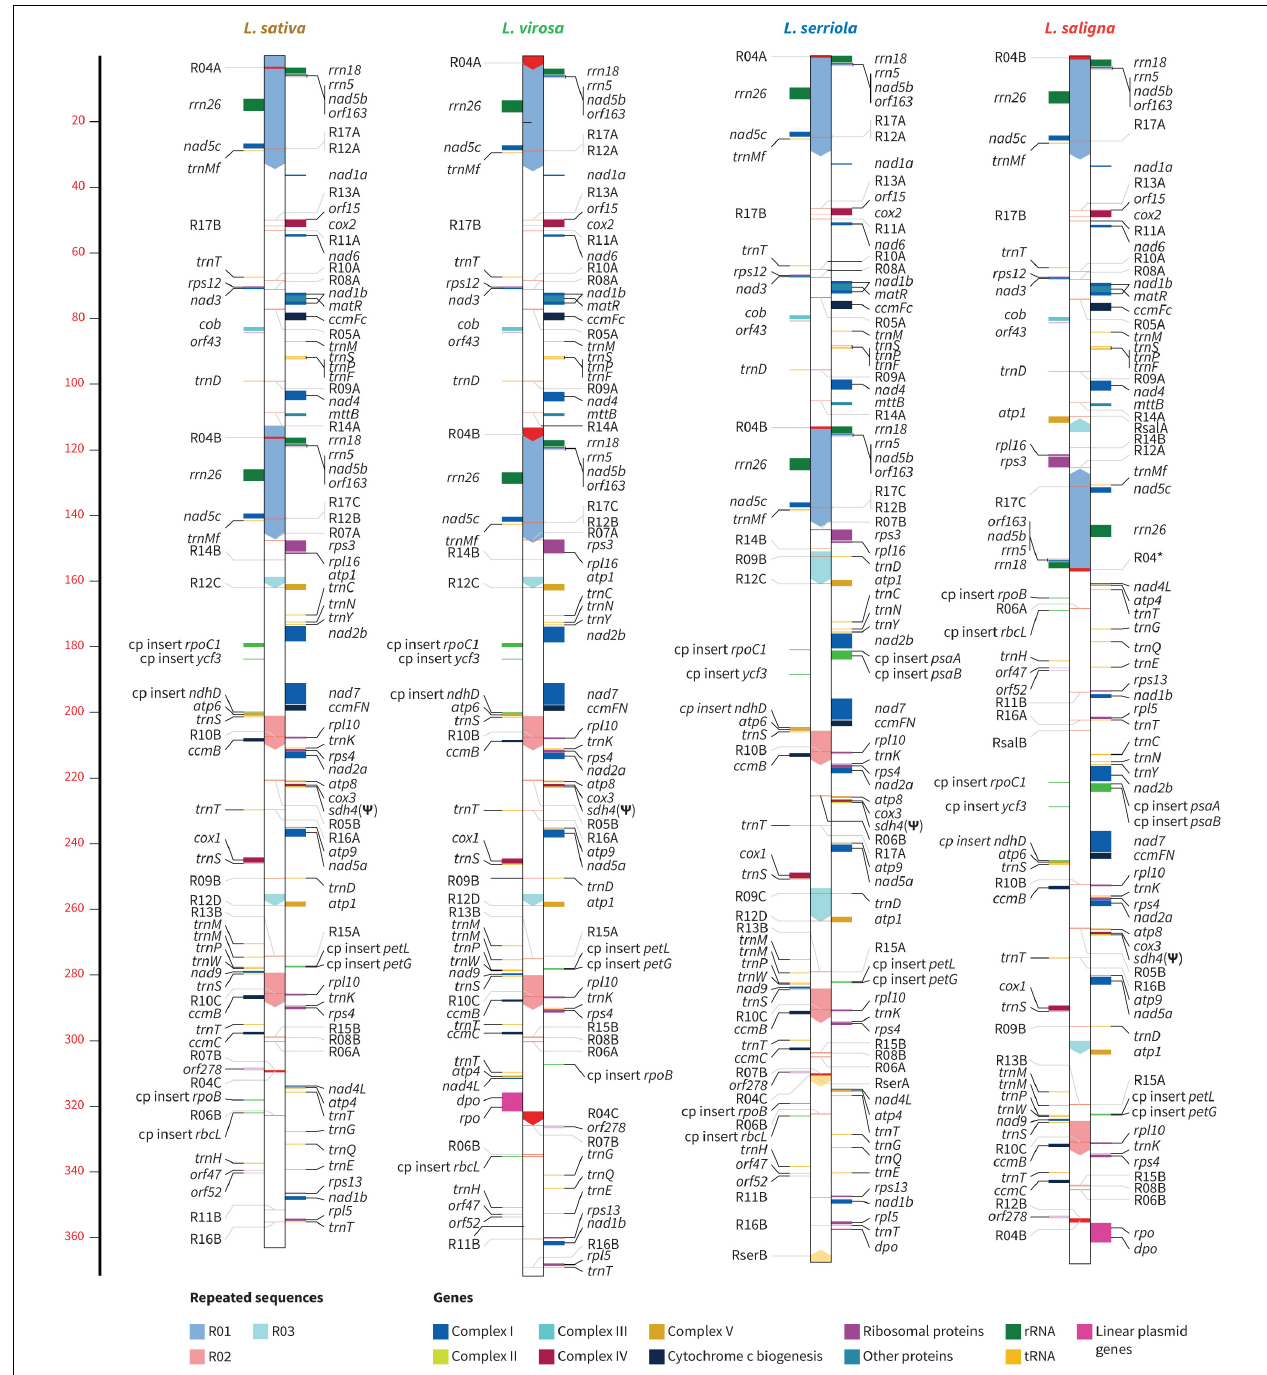
FIGURE 3 | Linear representations of lettuces mitochondrial genomes. The relative positions of genes are indicated by horizontal lines, color coded by function, as indicated in the key at the bottom right. Transcription direction is down for genes on the right of the genome bar and up for those on the left. Large repeats (0.5 kb) are indicated by arrowed boxes within each genome bar, which are color coded according to the key at the bottom left. Plastidial DNA insertions (annotated as “cp insert”) are highlighted in green. Scale is in kilobases.